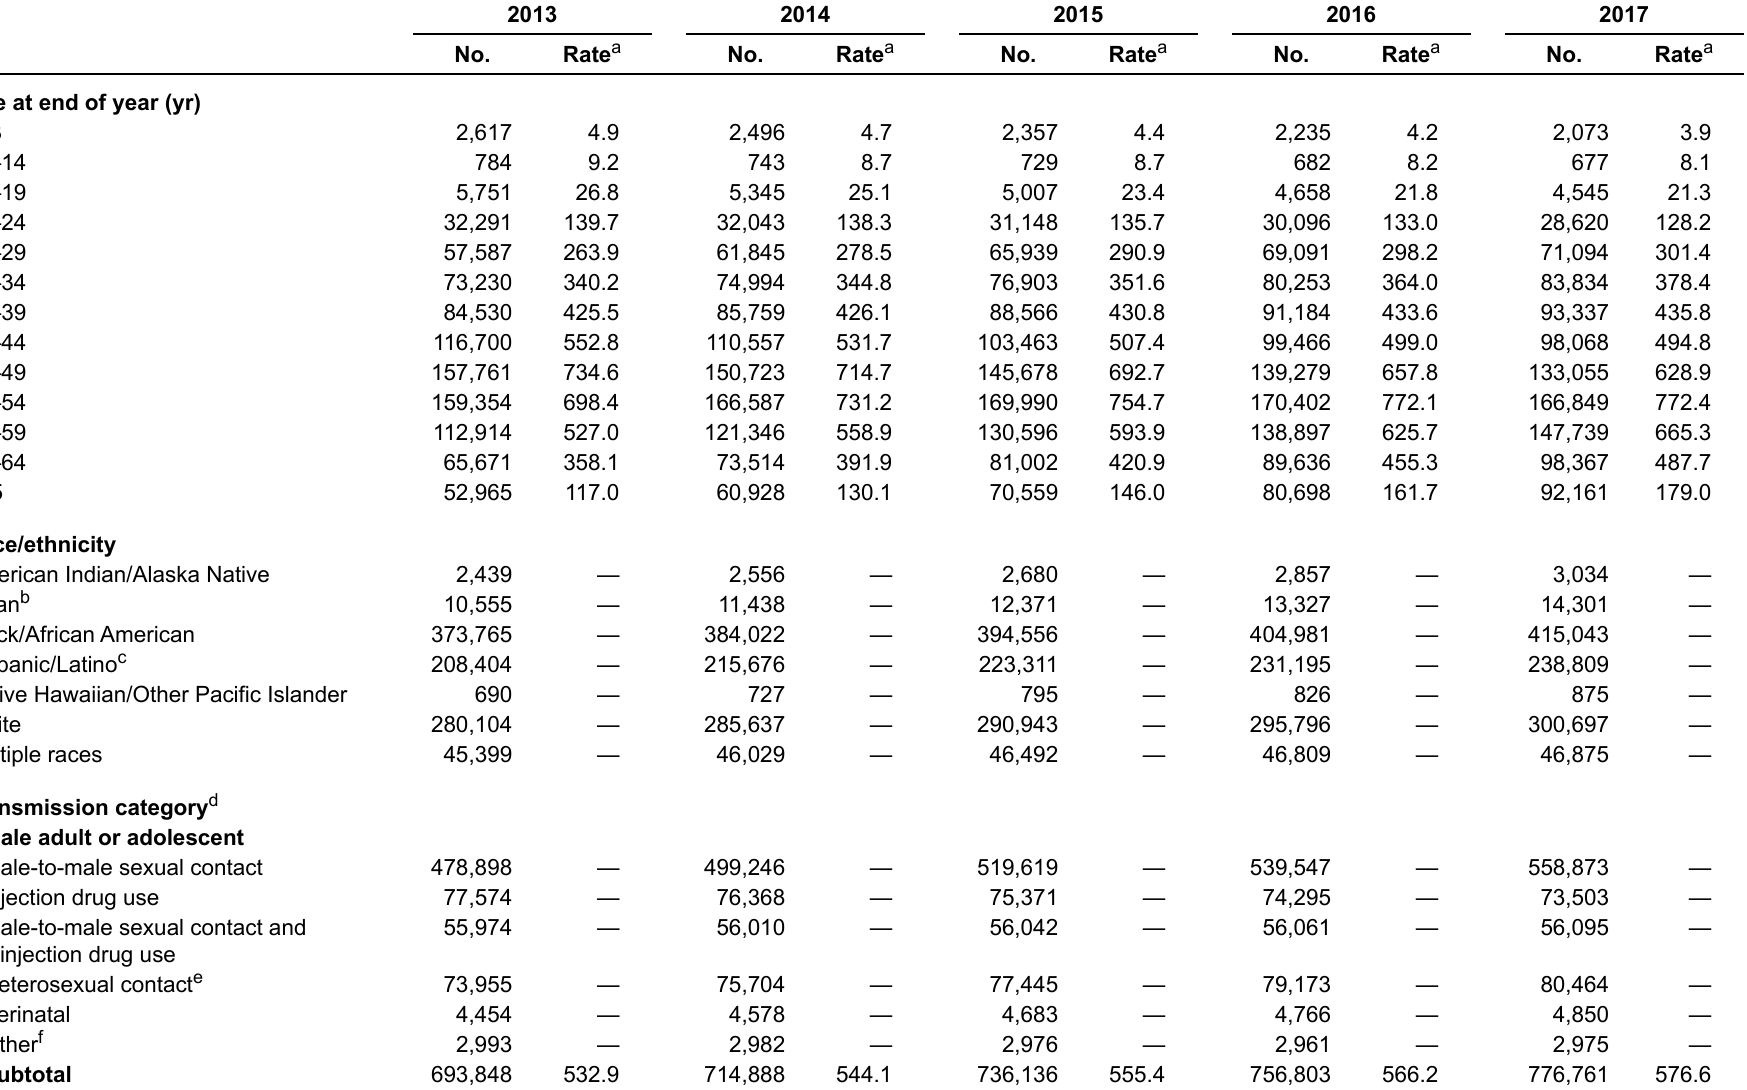
Table 22b. Persons living with diagnosed HIV infection, by year and selected characteristics, 2013–2017—United States and 6 dependent